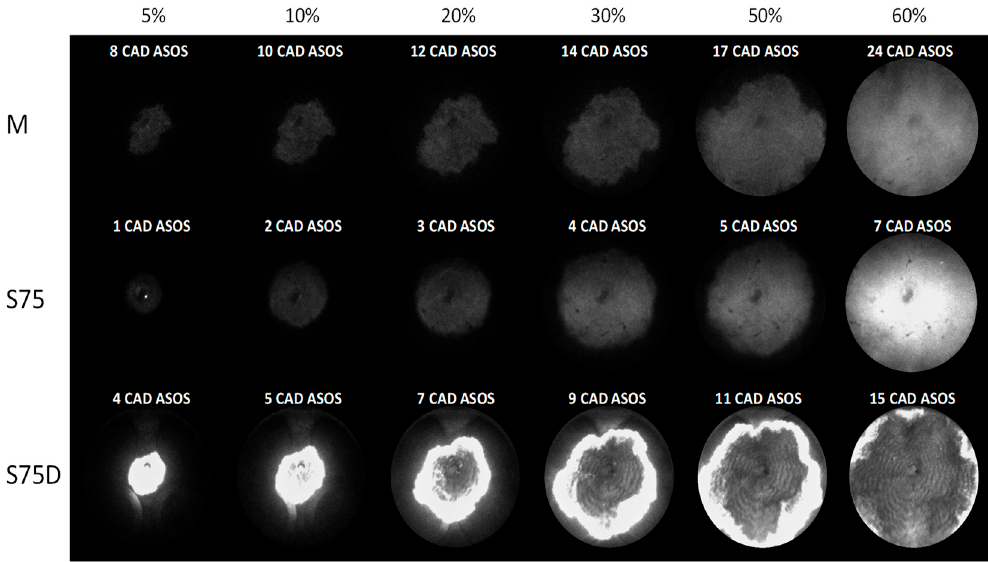
Figure 11. Image sequence of flame evolution at the same flame area (5%, 10%, 20%, 30%, 50% and 60% of the piston cross-section) for a stoichiometric air-fuel ratio ( λ = 1.0) with M, S75, and S75D fueling.